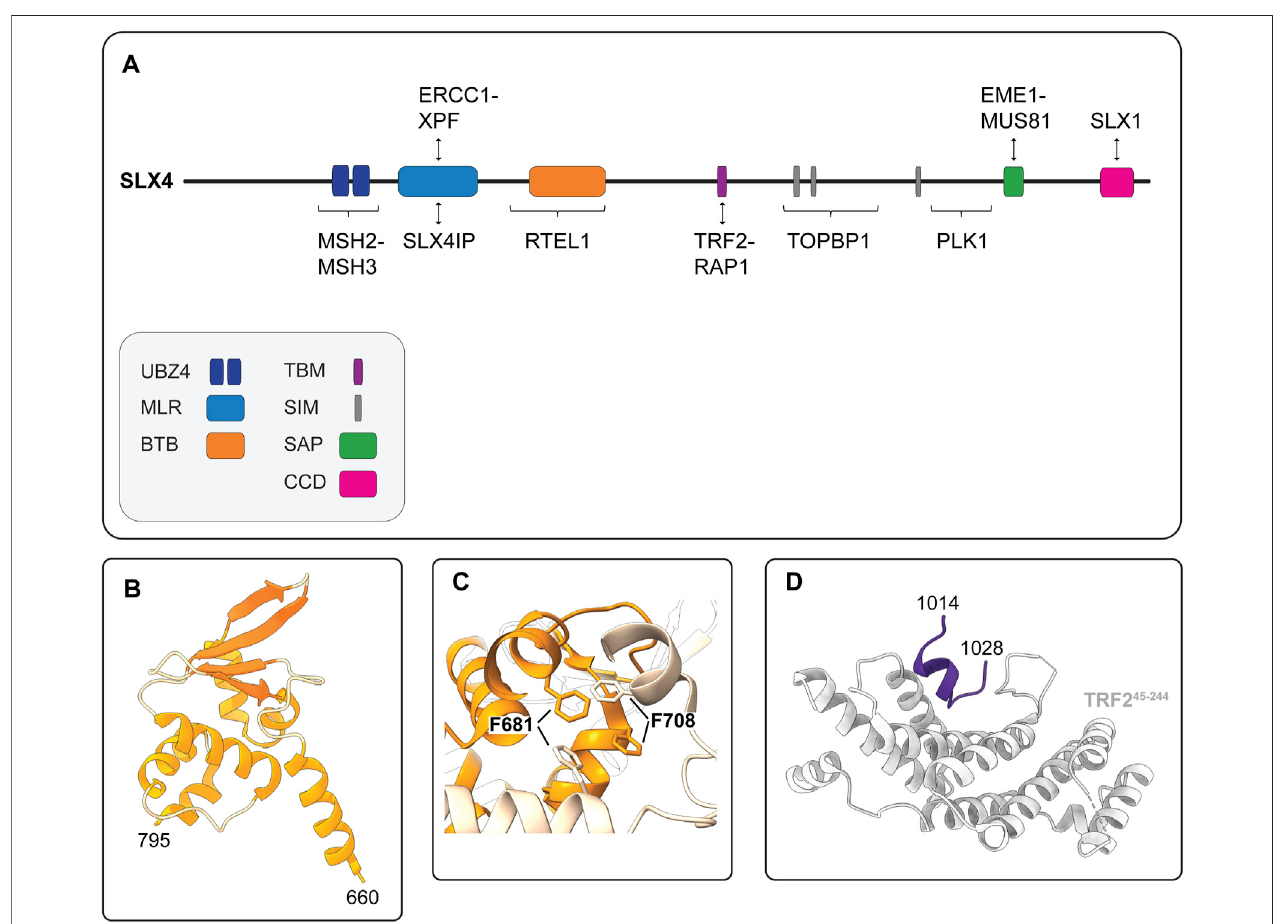
FIGURE 5 | Human SLX4 is a scaffold for proteins that have critical functions in DNA repair and genome stability. (A) Schematic representation of human SLX4 showing its domain organization and select protein partners. Domains are colored as indicated in the legend (lower left). Abbreviations for protein domains: UBZ4, ubiquitin-binding zinc fi nger type 4; MLR, MUS312-MEI9 interaction-like region; BTB, Broad-Complex, Tramtrack and Bric a Brac; TBM, TRF2-binding motif; SIM, SUMO-interacting motif; SAP, SAF-A/B, Acinus and PIAS; CCD, conserved C-terminal domain. (B) Crystal structure of the human SLX4 BTB domain, spanning residues660 – 795(PDB:4ZOU). (C) Close-upviewofthecriticalhydrophobicinteractionsbetweenF681andF708intheSLX4BTBdimerizationinterface(PDB:4ZOU). One monomer is shown in orange and the other is shown in peach. Residues F681 and F708 are shown in stick format. (D) Crystal structure of the human SLX4 TBM (shown in purple) bound to a fragment of TRF2 spanning residues 45 – 244 (shown in grey) (PDB: